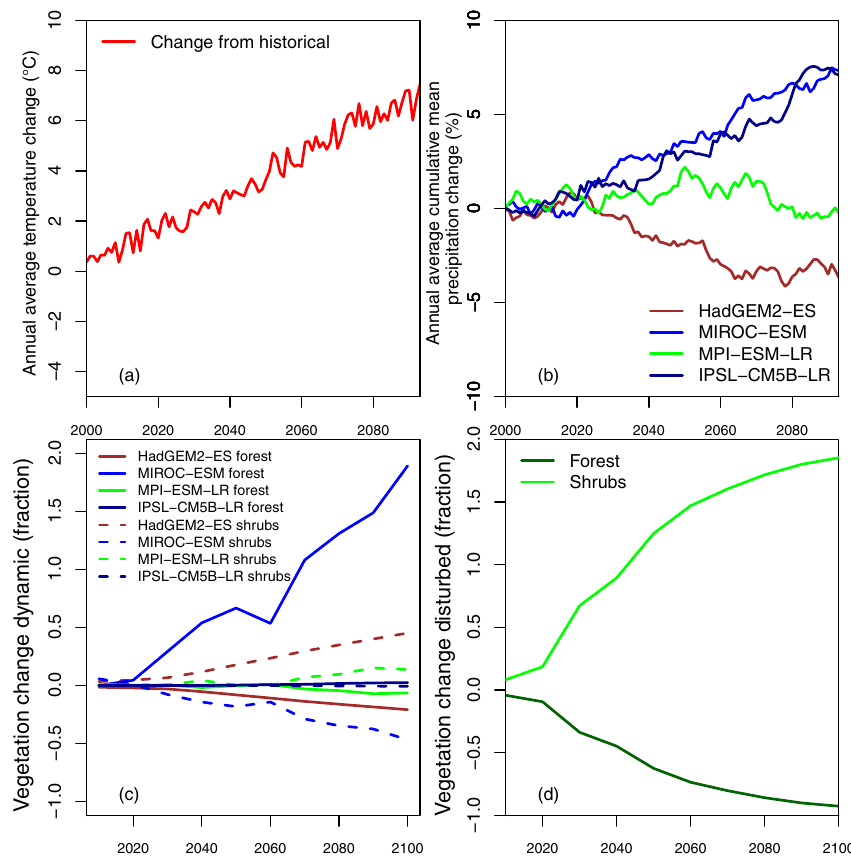
Figure 2. Temperature ( ◦ C, a ), precipitation (%, b ), and land cover (c, d) changes to the 2080s (2070–2099) averaged over the ESMs and spatially over the San Juan River basin (61560km 2 or 1570 grid cells). CMIP5 dynamic forest disturbances for the four ESMs as a difference from the historical climatology (1970–1999) illustrate a more moderate change with HadGEM2-ES projecting the largest decline and MIROC-ESM projecting an increase in forest cover (c) . The disturbed vegetation scenario based on McDowell et al. (2016) (d) illustrates strongly declining forest covers ( > 50% forest loss) and increasing shrub